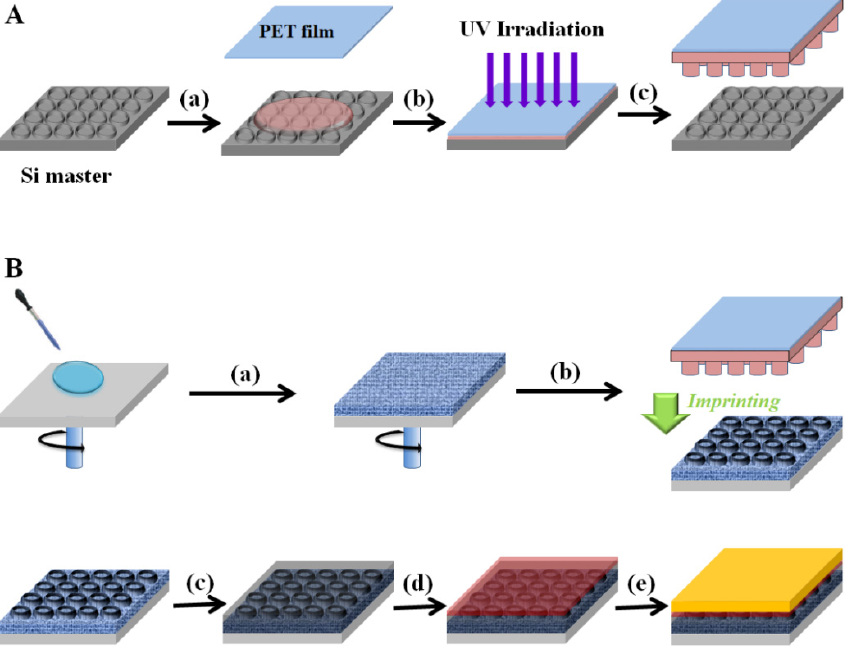
Figure 1. ( A ) Preparation of perfluoropolyether (PFPE) mold from the Si master: ( a ) PFPE resin and polyethylene terephthalate (PET) film, ( b ) irradiation of UV, and ( c ) PFPE mold. ( B ) Fabrication of perovskite solar cells with a nanopatterned mesoporous TiO 2 (mp-TiO 2 ) thin-film layer: ( a ) coating of mp-TiO 2 thin-film layer, ( b ) nanopatterning of mp-TiO 2 thin-film layer through imprinting method, ( c ) coating of perovskite, ( d ) coating of spiro-OMeTAD as hole transport material, and ( e ) evaporation of Au.